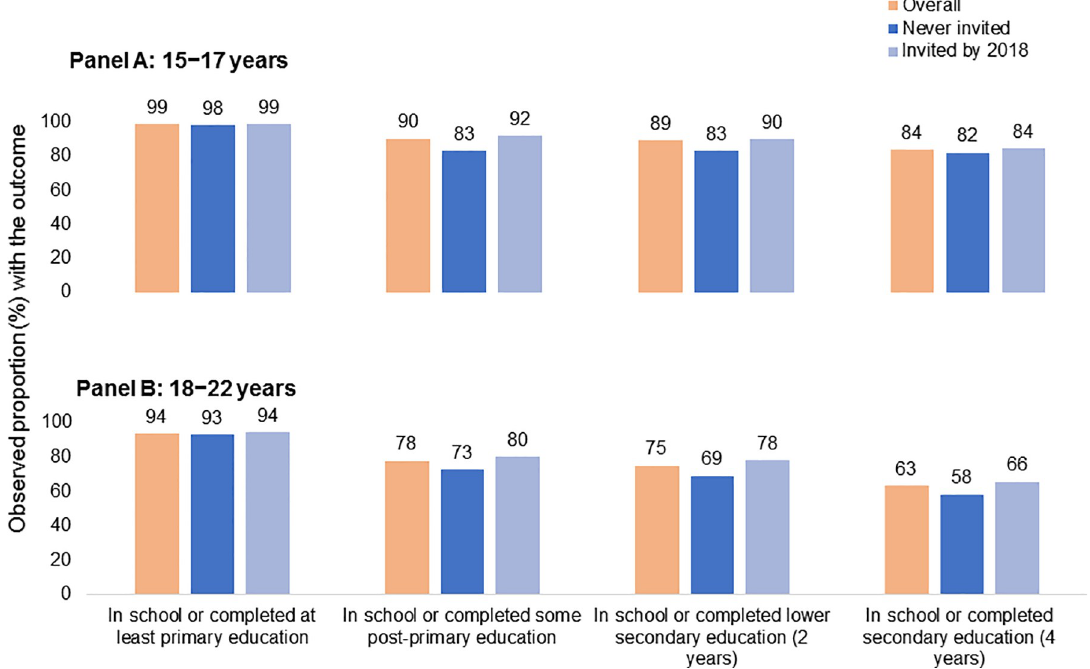
Fig 2. Educational attainment at endline among AGYW aged 15–22 years by invitation to DREAMS and age at enrolment. Denominators: Among 15–17 years, total N = 464; invited by 2018 N = 369; Among 18–22 years, total N = 388; invited by 2018 N = 259.